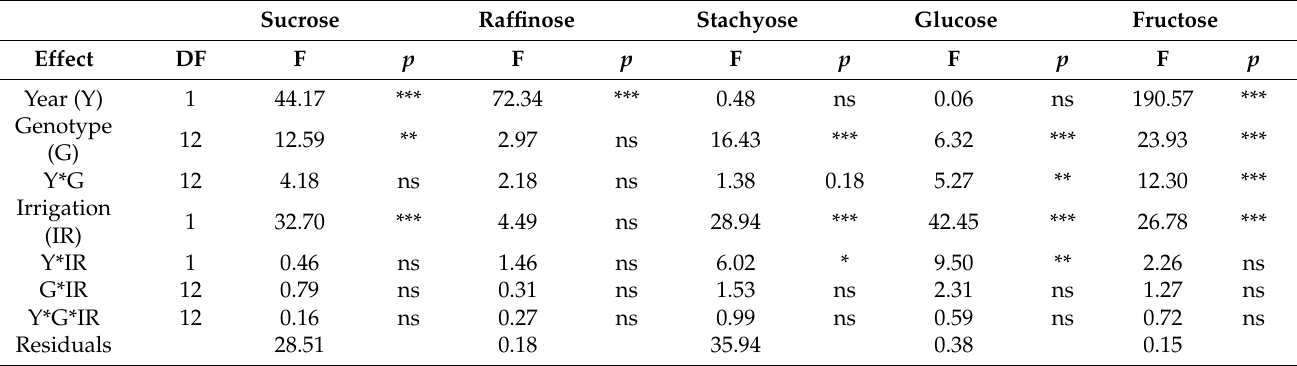
Table 3. Analysis of variance (ANOVA) of the effects of the main factors (year, genotype, irrigation), and their interactions, on seed sugars (mg/g) (sucrose, raffinose, stachyose, glucose, and fructose) among 13 soybean genotypes. The experiment was conducted in 2012 and 2013 in Jackson, TN, USA. Sucrose Raffinose Stachyose Glucose Fructose